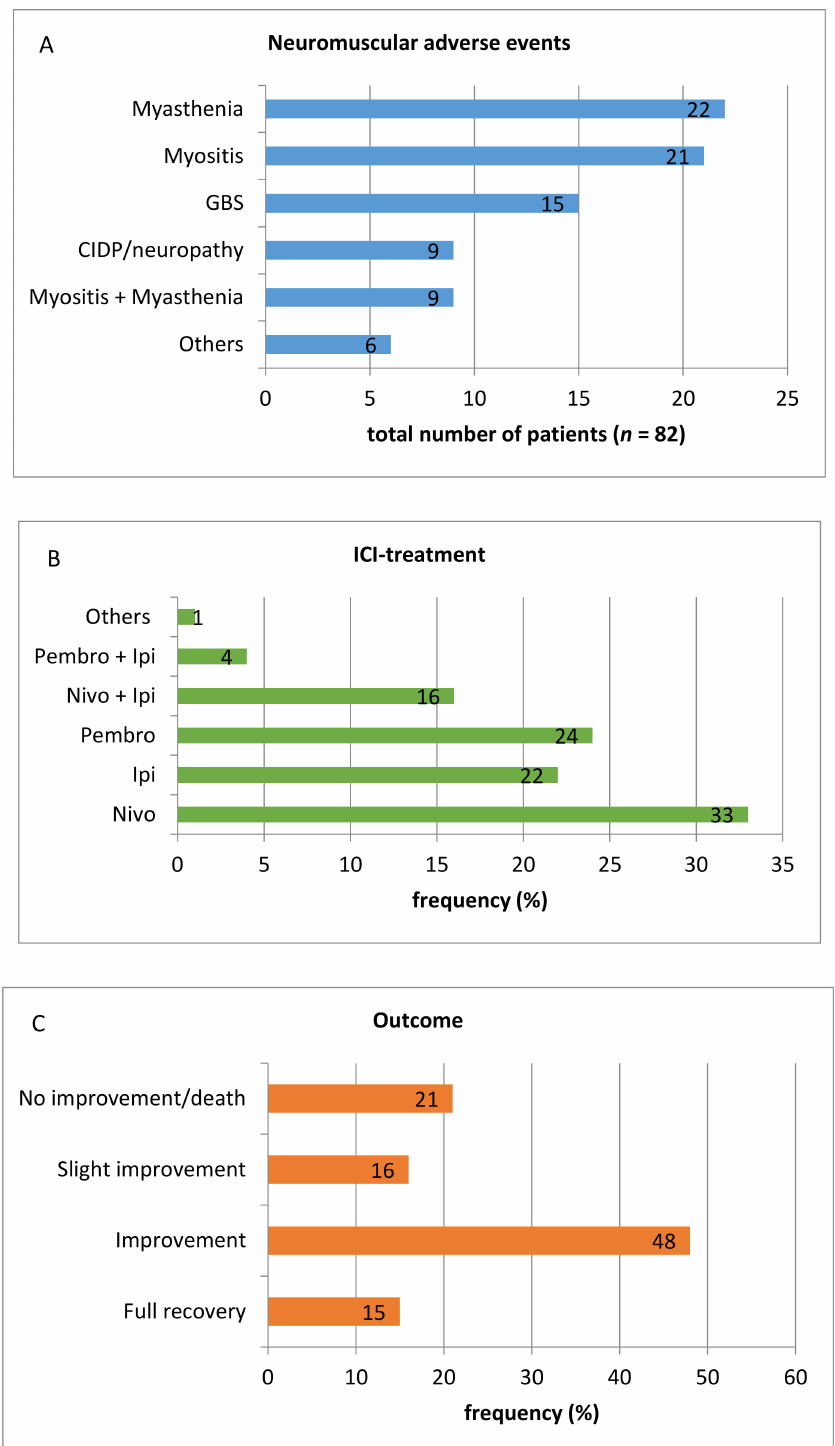
Figure 2. Number of di ff erent neuromuscular adverse events ( A ), frequency distribution of underlying ICI-therapy ( B ), and outcome after neuromuscular adverse events ( C ) in analysed case reports of ICI-mediated neurological adverse events. CIDP: Chronic inflammatory demyelinating polyneuropathy; GBS: Guillain-Barr é syndrome; ICI: Immune-checkpoint inhibitor; Ipi: Ipilimumab; Nivo: Nivolumab; Pembro: